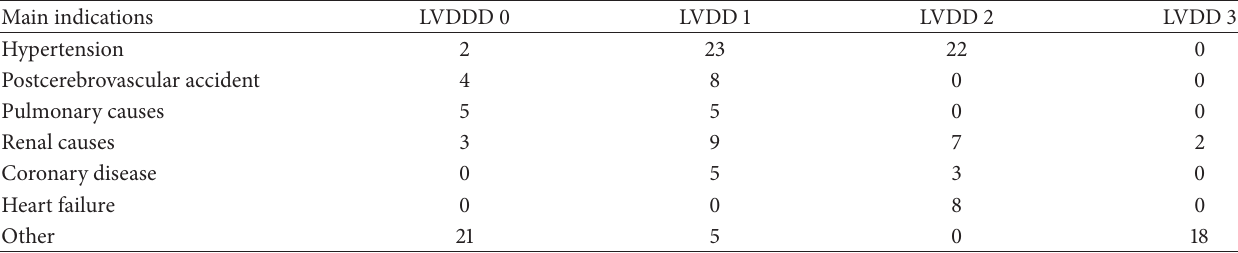
Table 1: Clinical indication to perform echocardiogram.